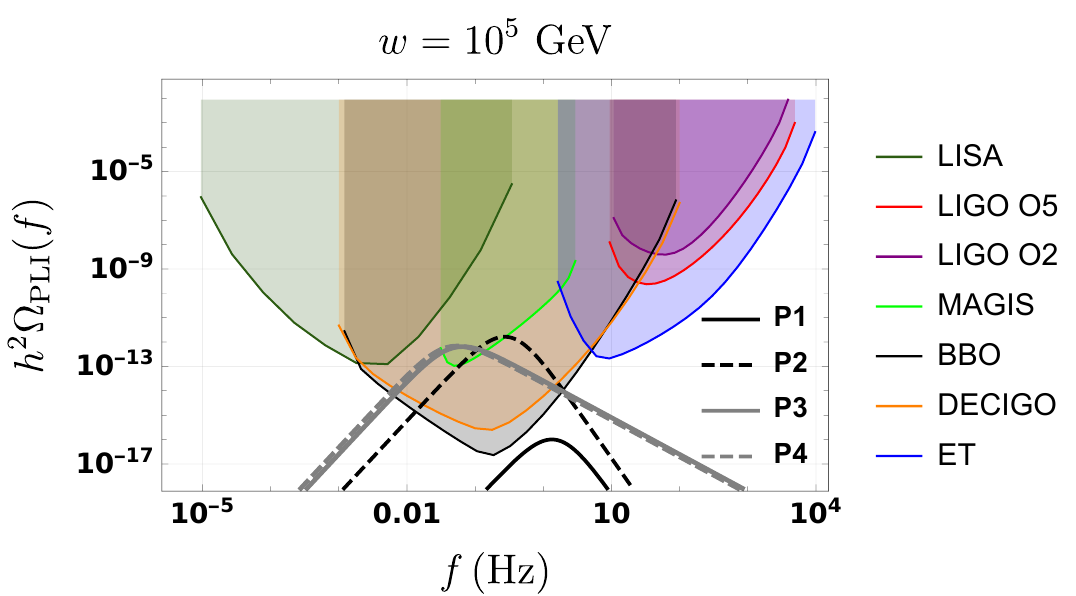
Figure 5 . We represent the expected stochastic gravitational signal of the P1-P4 reference points. The spectrum is dominated by the bubble collision term for P3-P4 and by the sound waves term for P1-P2 . On the top of it, we put the PLI sensitivity curves of the coming experiments: LISA, LIGO O2 and O5, MAGIS, BBO, DECIGO and ET. We see that the points P2-P4 are well into the range of detection of DECIGO and BBO. The dominant contribution for those points is the bubble collision, or scalar (cid:12)eld, while the e(cid:14)ciency factor of the sound waves contribution is largely suppressed by a factor (cid:24) (cid:11) 1 . For the point P2 , only the sound waves component contributes to the (cid:11) signal with (cid:20) (cid:13)uid = 1 and we expect P1 to be outside of the detection window as it is suppressed by (cid:11) (cid:24) 0 : 042. We can also see the di(cid:11)erence of behaviour between sound waves fuelled GW, fading as (cid:10) sw (cid:24) f (cid:0) 4 , much faster than the bubble component, fading as (cid:10) (cid:30) (cid:24) f (cid:0) 3 = 2 . The signal-to-noise ratio and the sensitivity curves can be build following the recommendations of